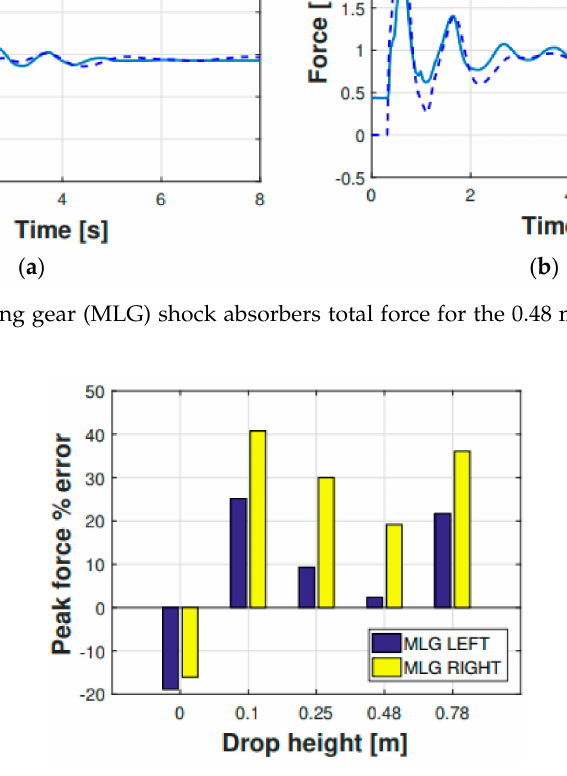
Figure 9. Percentage error between the experimental and numerical (multibody) MLG (right and left) peak forces for each drop